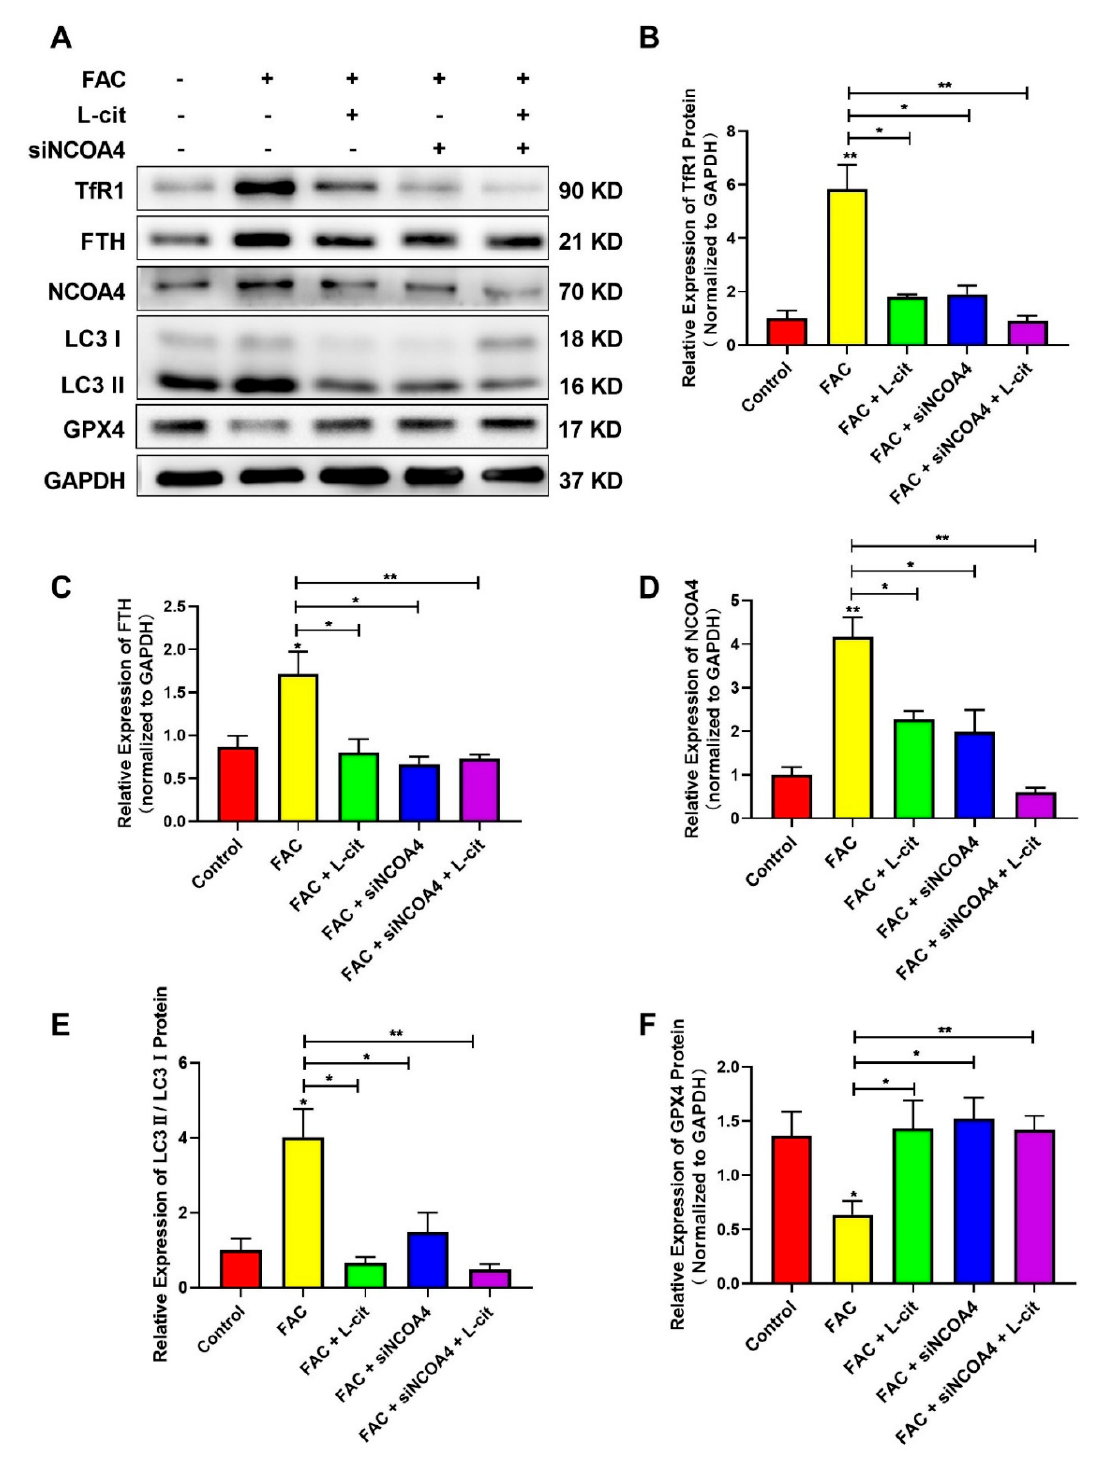
Figure 8. L-cit restrains ferritinophagy to suppress ferroptosis induced by FAC in mTEC1 cells. The mTEC1 cells were transfected with 50 nM siNCOA4, followed by 2 mM L-cit, and treated with 200 µ M FAC for 24 h. ( A , B ) Immunoblot analyses of TFR1. ( A , C ) Immunoblot analyses of FTH. ( A , D ) Immunoblot analyses of NCOA4. ( A , E ) Immunoblot analyses of LC3. ( A , F ) Immunoblot analyses of GPX4. GAPDH was used as the loading control. Values represent mean ± SEM. of three independent experiments. Significant differences are represented by * p < 0.05, ** p < 0.01, ns (not significant).